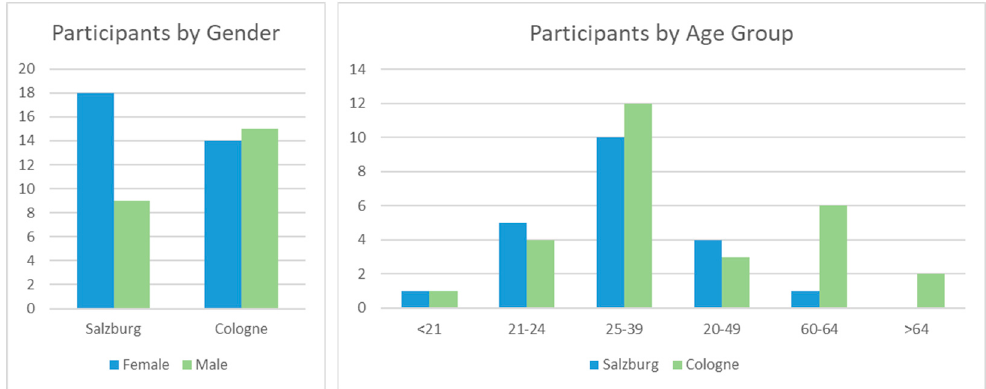
Figure 2. Gender and Age Distribution of the Study Participants.